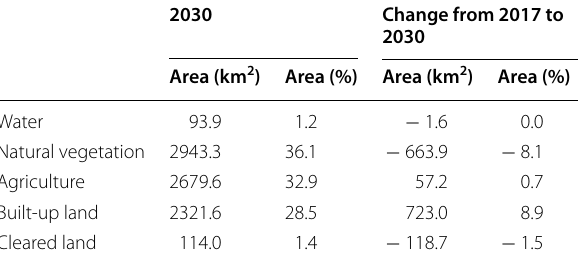
Table 4 The area of land cover for the simulated year 2030, and changes between 2017 and